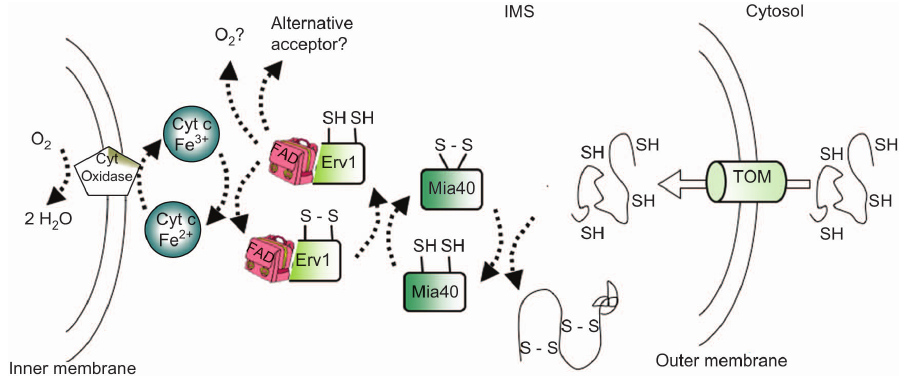
Figure 2 Oxidative folding in the mitochondrial IMS. Proteins destined for the IMS are synthesized in the cytosol, then they are translocated through the outer mitochondrial membrane in reduced, unfolded conformation. Oxidized Mia40 recognizes and oxidizes its substrates, catalyzing the folding by disulfide bond generation. Reduced Mia40, in turn, will be reoxidized by an electron transfer chain containing Erv1, cytochrome c and cytochrome